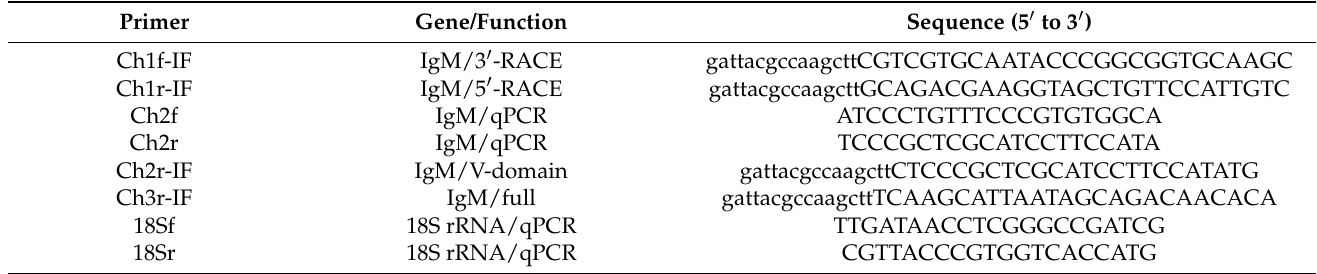
Table 1. Primers used in this study 1